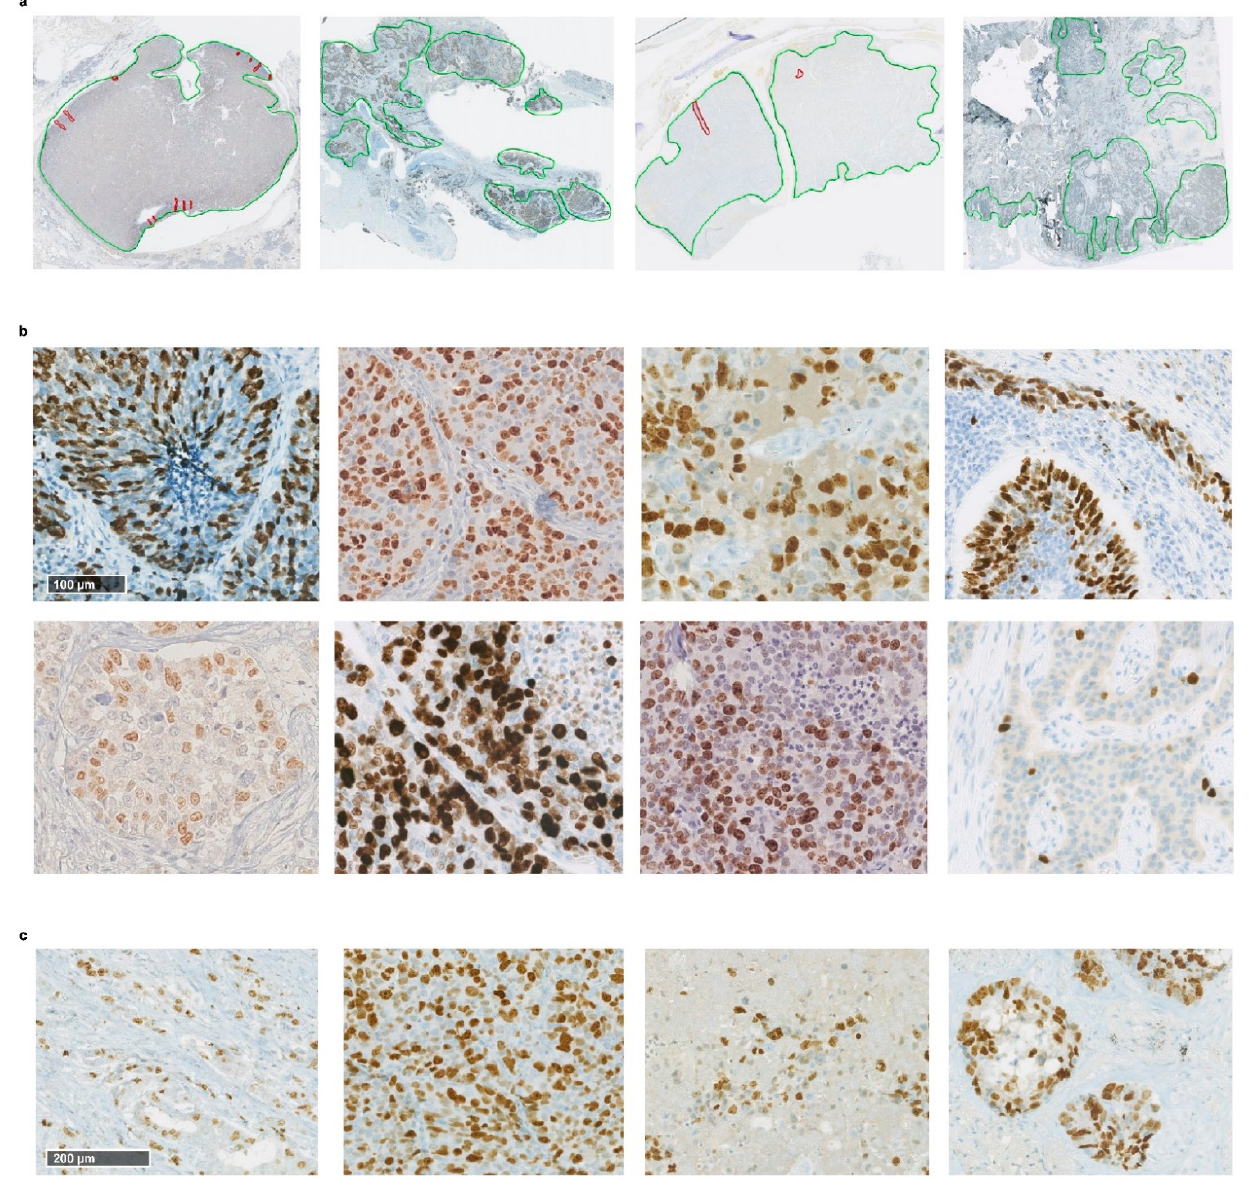
Figure 6. ( a ) Examples of outlined WSIs from our dataset. Each presents a different number of outlined regions, with unique shapes and sizes. ( b ) Examples of hue and texture variability between samples. Each image presents a unique landscape, with peculiar colouring and cell disposition patterns. ( c ) Variability of texture and cellular organisation patterns within the same WSI.